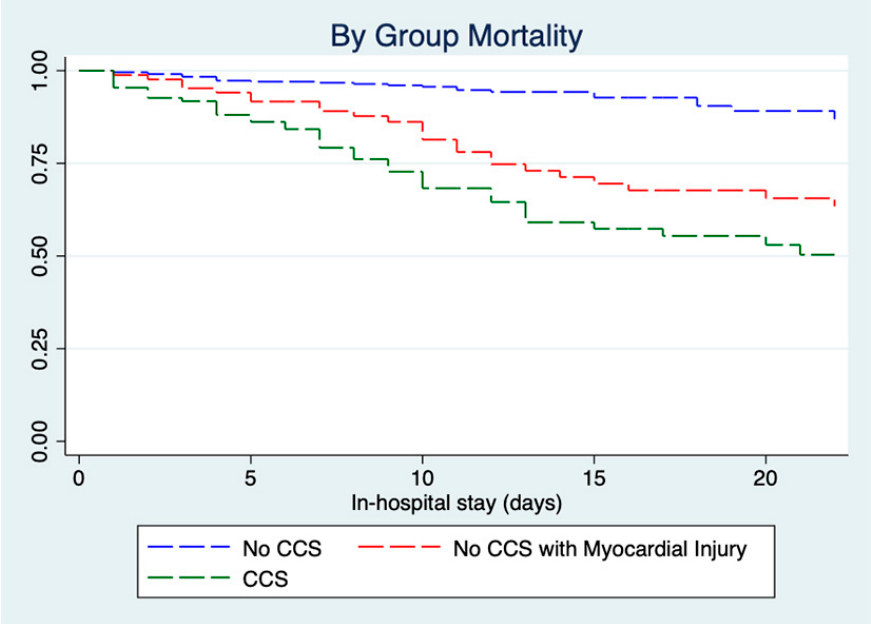
Figure 2. Kaplan–Meier survival curves for CCS patients, no-CCS patients, and no-CCS patients developing myocardial injury during in-hospital stay. Abbreviations : CCS: chronic coronary syndromes.